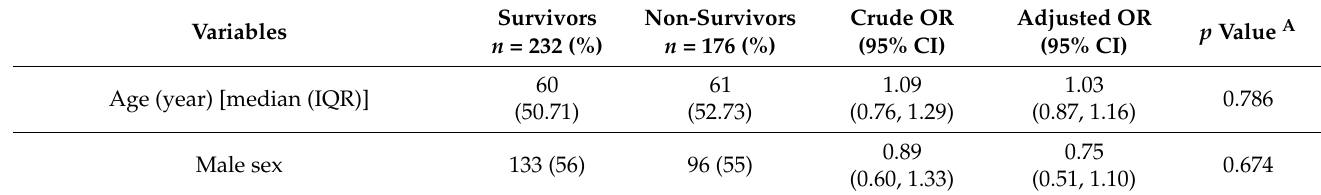
Table 7. Factors associated with in-hospital mortality among the patients with community-acquired pneumonia (CAP) due to due to coronavirus disease 2019